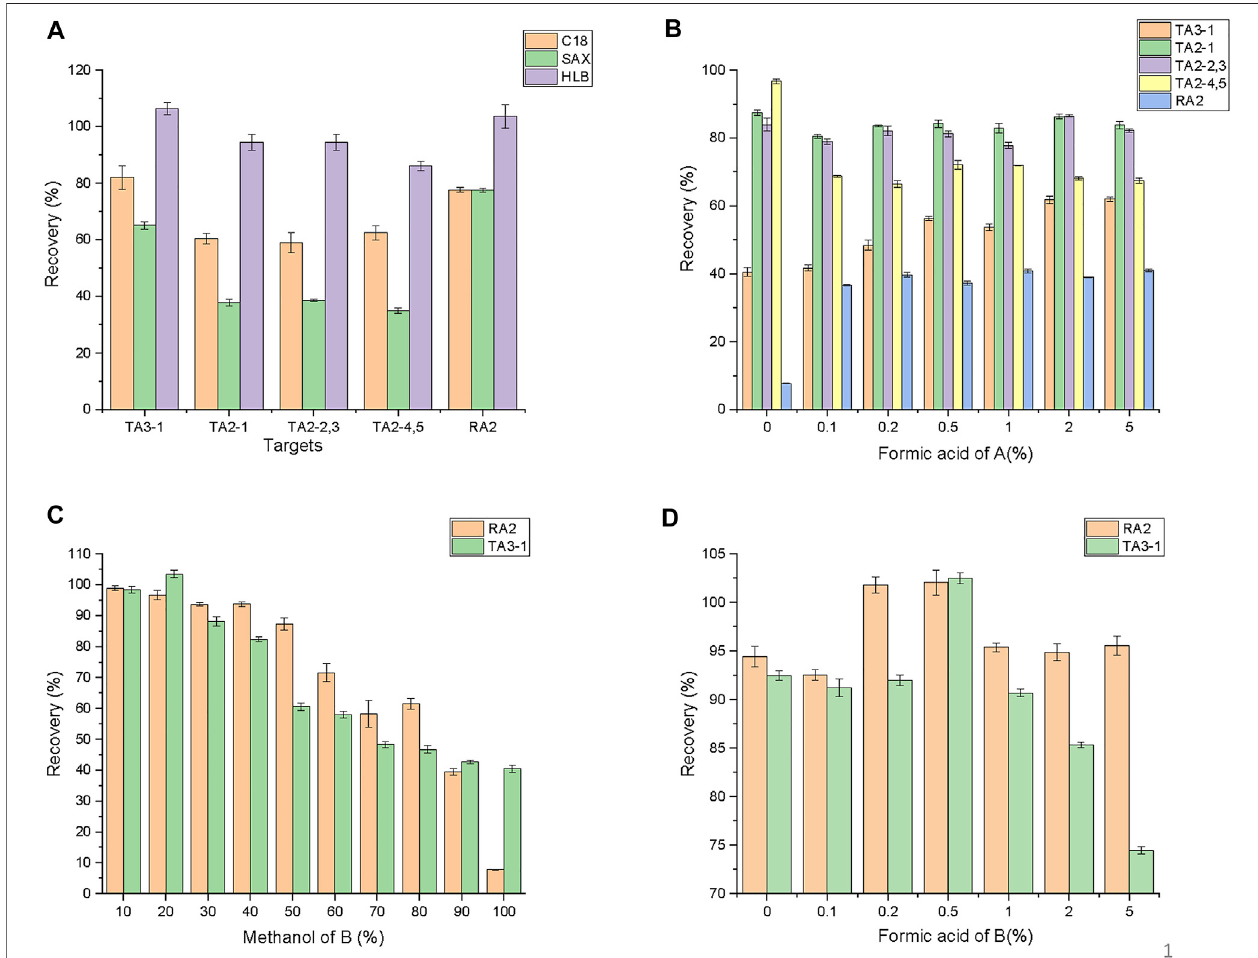
FIGURE 3 | Optimization of SPE procedures. (A) for SPE columns; (B) for concentrations of formic acid in eluent A, formic acid of A means the concentrations of formic acidinmethanol; (C) forcontentsofmethanolineluent B,methanol ofB meantheconcentrationsofmethanol inwater; (D) for contentsofformicacidineluent B, formic acid of B means the concentrations of formic acid in 20% methanol